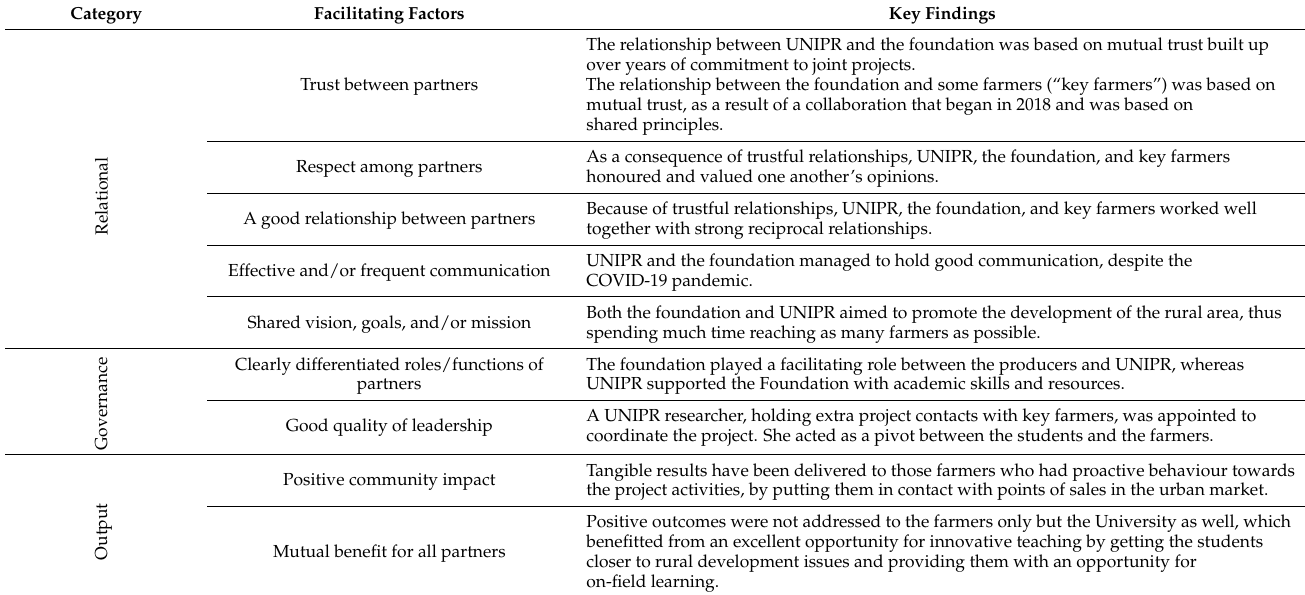
Table 3. Facilitating factors of the “Parma, mountains of quality” project.